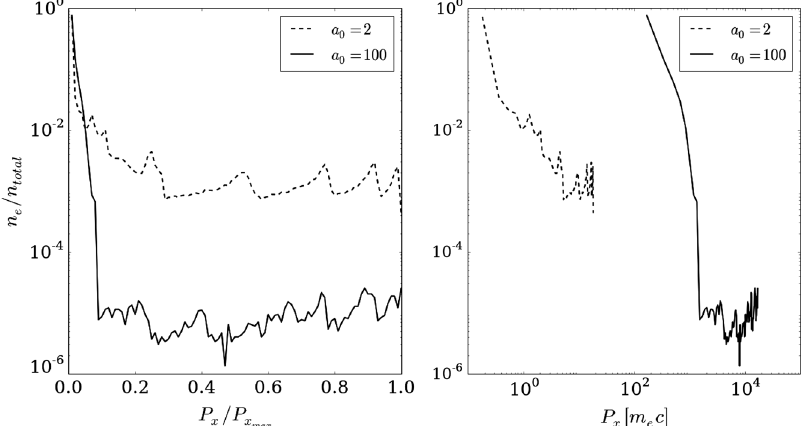
FIG. 7. The momentum spectra of accelerated particles, ultrarelativistic case with mass ratio ¼ 1836 , (a) semilog and (b) log-log. The high energy spectra are well extended, while they show particular